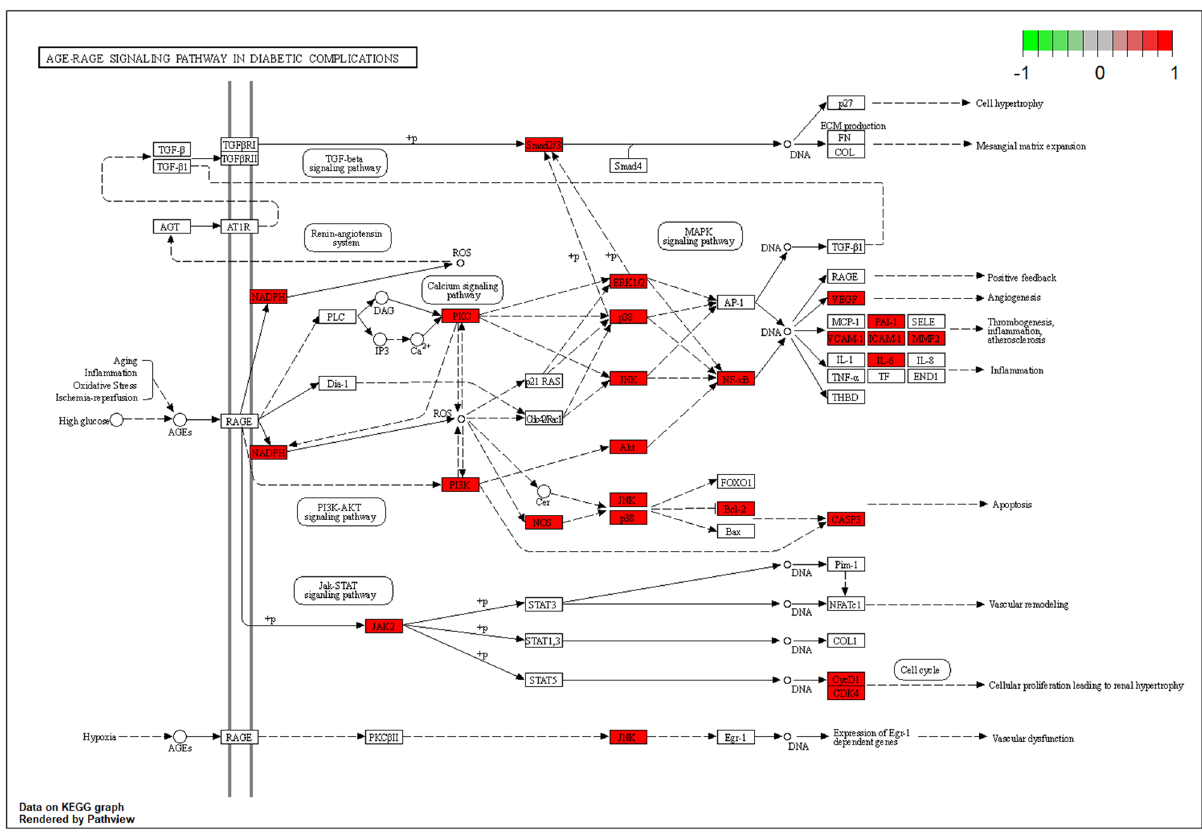
Figure 10. AGE-RAGE signaling pathway in diabetic complications. The red rectangle represents the targets related to the core component-target-pathway